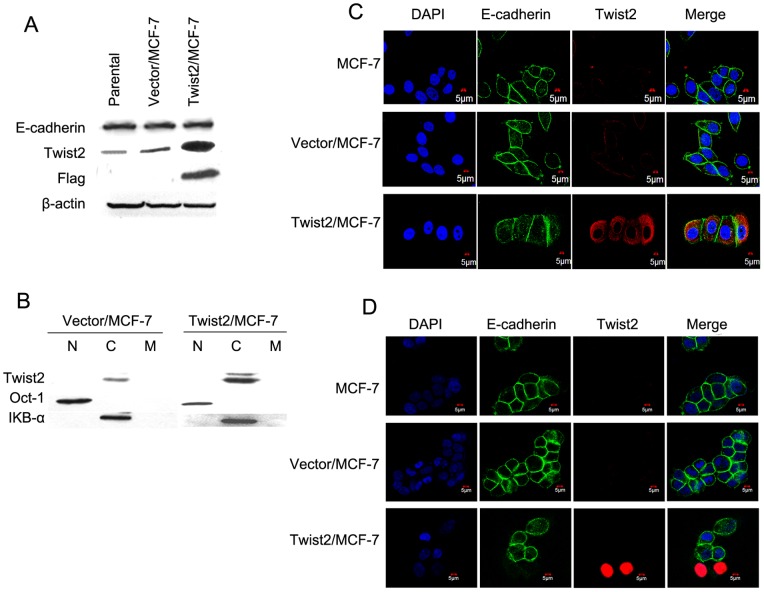
The regulation of E-cadherin expression by Twist2 in breast cancer cells.
A. Immunoblot analysis showing that strong expression of E-cadherin was found with cytoplasic Twist2 expression. Stable expression of ectopic Twist2 in breast cancer cells (Twist2/MCF-7) were verified by western blot with anti- Twist2 and anti-flag antibodies. No obvious changes of E-cadherin was detected between Twist2/MCF-7, Vec/MCF-7 (the vector control), and the parental group. B. Immunoblot analysis of Twist2 in subcellular fractions showing that Twist2 was localized in the cytoplasm. Oct-1 indicated nuclear fraction and IkB-α indicated cytoplasmic fraction. The cells were from the stably transfected samples. C. Immunofluorescent staining of Twist2 and E-cadherin in MCF-7 cells showing cells with Twist2 (in red) in cytoplasm expressed E-cadherin (in green) on cell membrane. Nuclei were counterstained with DAPI (in blue). The cells were from the stably transfected samples. D. Immunofluorescent staining showing that transient over-expression of Twist2 (in red) in nuclei caused loss of E-cadherin in the same cancer cells. Cells without nuclear Twist2 retained expression of E-cadherin on membrane. Nuclei were counterstained with DAPI (in blue).